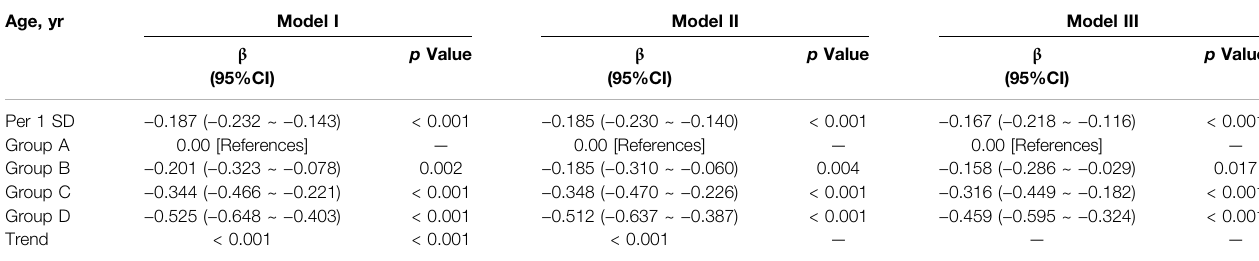
TABLE 4 | Effects of age on propofol requirement.